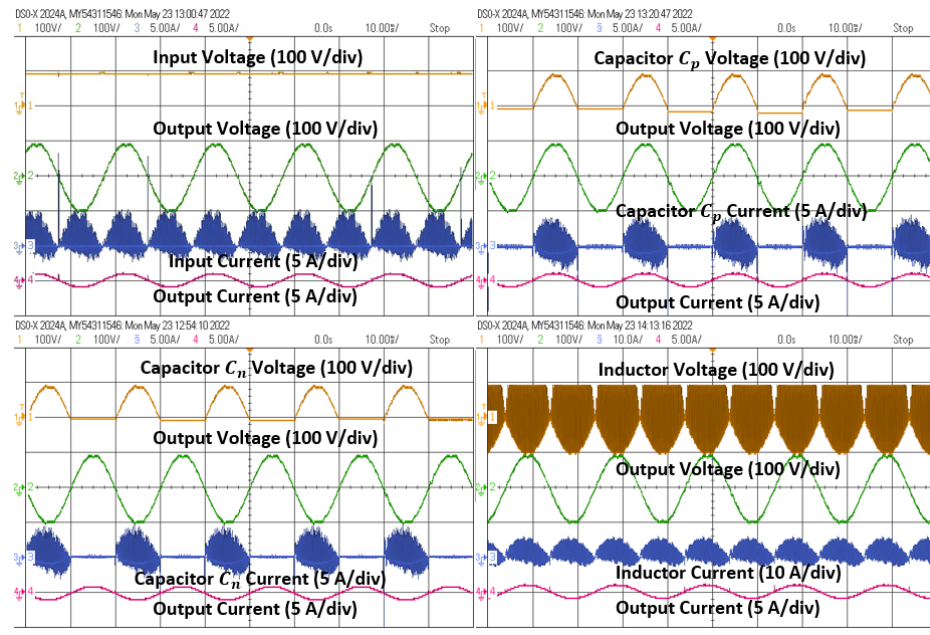
Figure 9. Steady-state response of mode 3 at G = 1.